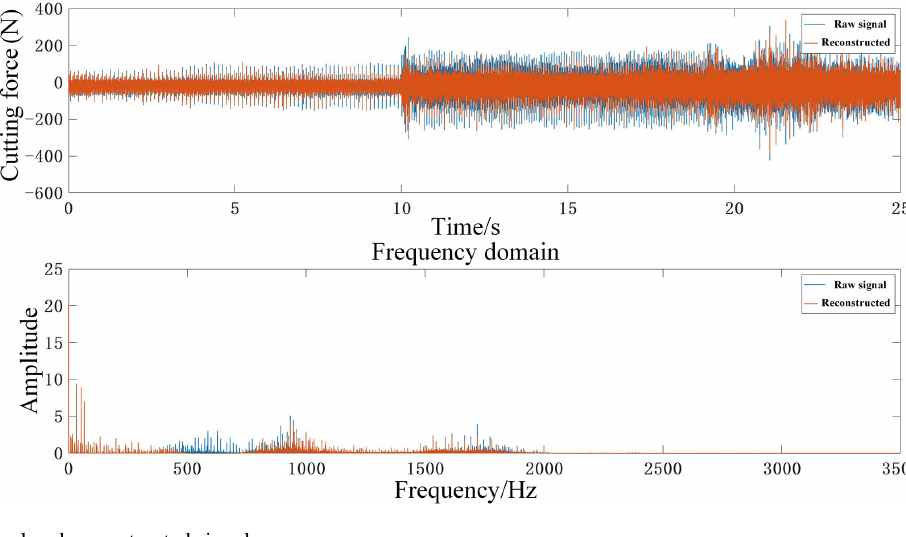
Figure 9. Raw signal and reconstructed signal.